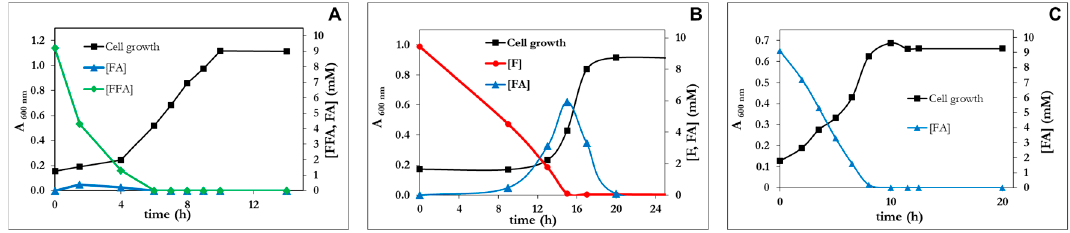
Figure 5. Growth curves of P. pseudoalcaligenes CECT 5344 R1D with furfuryl alcohol ( A ), furfural ( B ) or furoic acid ( C ) as the sole carbon sources (10 mM). The concentration of furanic intermediates in the culture media was measured by HPLC at the indicated times. Each experiment was done in triplicate giving similar results.